Question: Provide a publication-style caption for this figure.
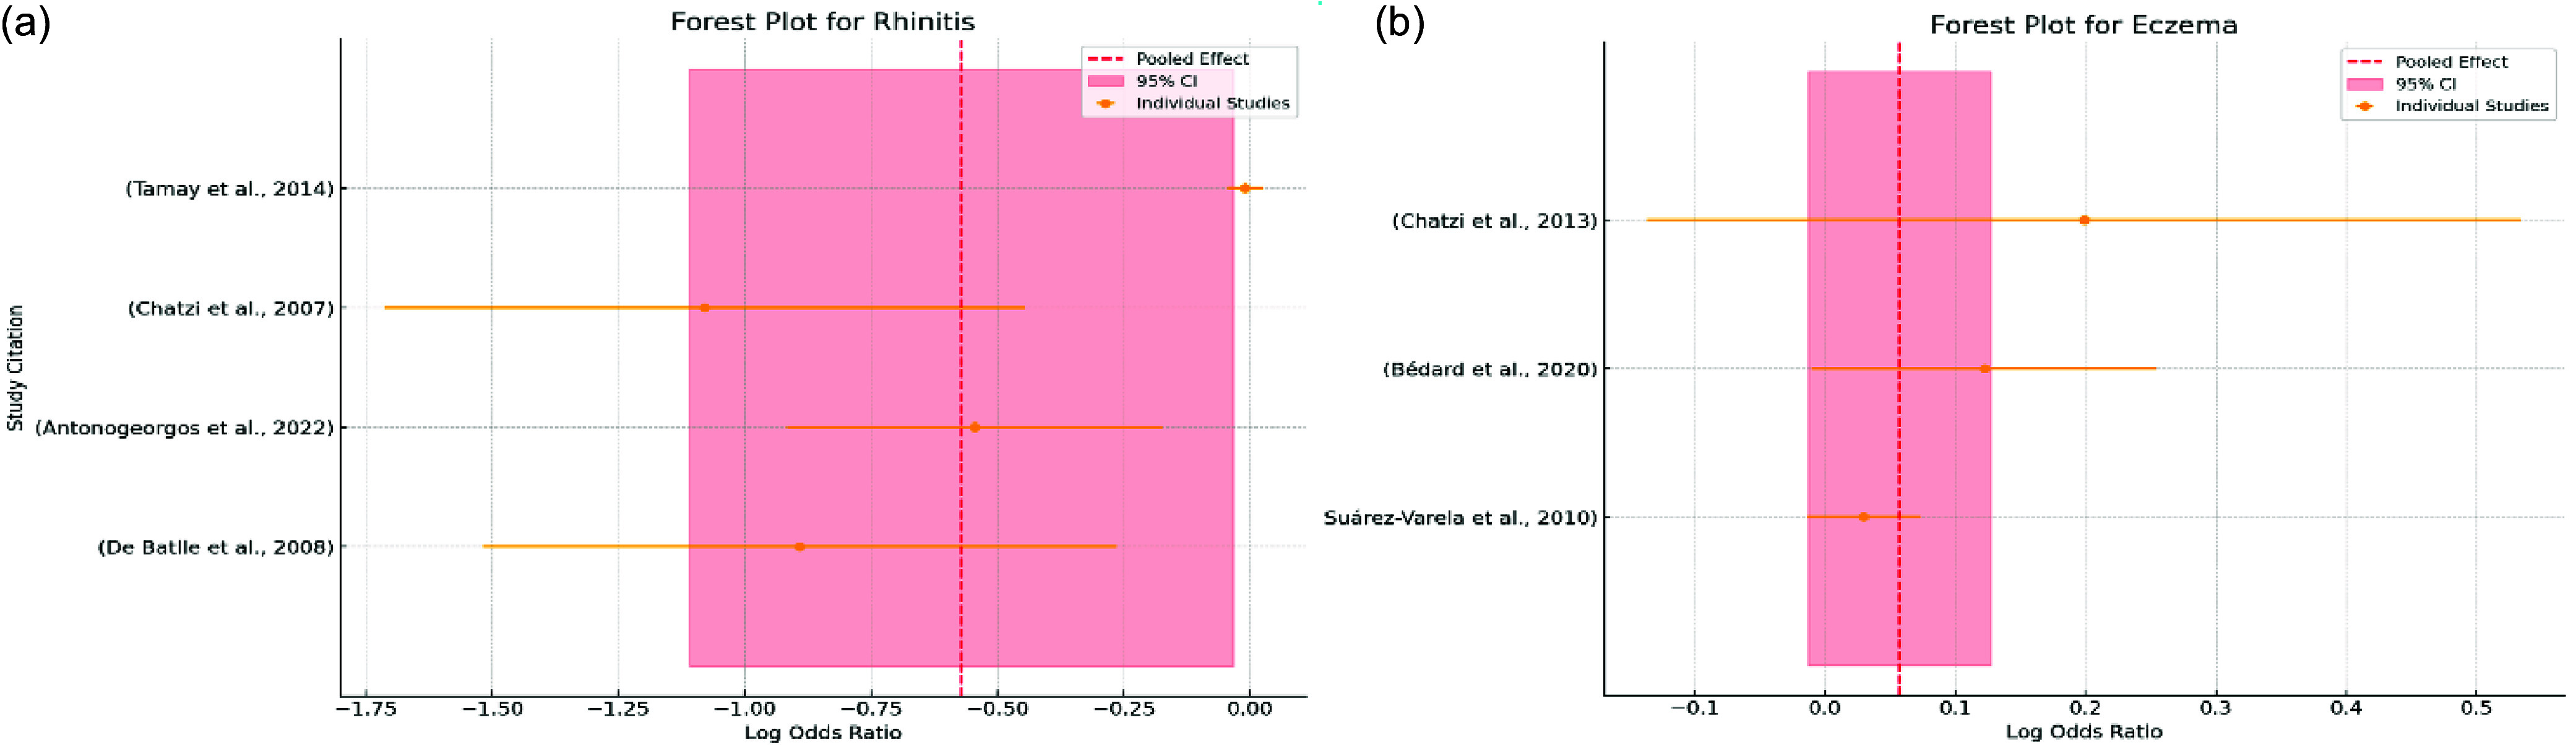
Answer: long description. Forest plots showing the effects of the MD on (a) rhinitis and (b) eczema.